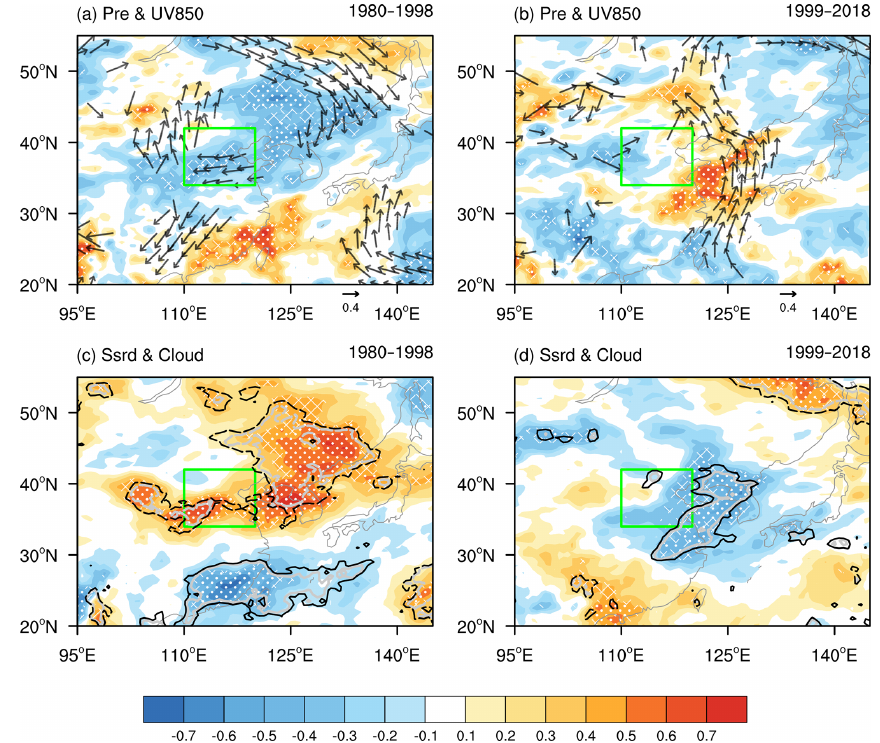
Figure 7. The meteorological conditions associated with SC WS ×− 1. (a, b) The correlation coefficients between SC WS ×− 1 and precip- itation (shading) and wind at 850hPa (arrow); (c, d) surface incoming shortwave flux (shading) and the sum of low and medium cloud cover (contour) from 1980 to 1998 (a, c) and from 1999 to 2018 (b, d) . The white dots (hatching) indicate that the correlation coefficients represented with shading exceeded the 95% (90%) confidence level ( t test). The gray (black) contours exceeded the 95% (90%) confidence level. The green boxes represent the location of North China. The linear trend is removed.